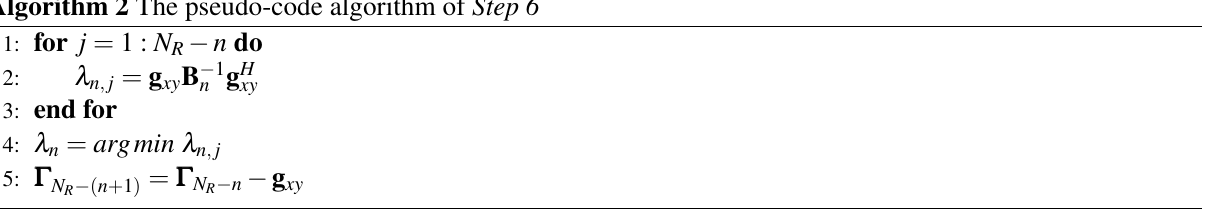
Algorithm 2 The pseudo-code algorithm of Step